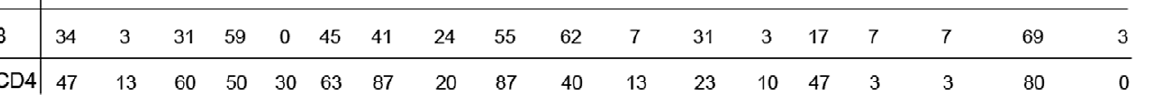
Figure 2. The help effect selectively expands fully differentiated T EM CD8 + T cells. ( A ) 1 to 2 6 10 4 CD8 + T cells were transferred alone or with 2 6 10 4 CD4 + T cells into CD3 e 2 / 2 hosts. Mice were sacrificed 8 weeks after the transfer and CD8 + CD44 high CD62L low cells from the lymph node were single-cell sorted. Multiplex RT-PCR of 19 genes was performed on 32 single-cells for the two groups. For each individual cell, black squares indicate that mRNA gene expression was detected; white squares indicate that the mRNA for the corresponding gene was absent (=0) [28]. ( B ) The table shows the percent of cells positive for each gene for the two groups of cells detailed in (A). Cytotoxic cells require co-expression of both Perforin and Granzymes A and B [27]. These cells could only be found among ‘‘helped’’ CD8 + T cells. Please note that ‘‘helped’’ CD8 + T cells harbored a significant fraction of cells expressing Il2 and Il15 mRNAs, which are very rarely expressed during antigen-specific responses and the expression of which is absent in memory T cells [28]. ‘‘Helped’’ CD8 + T cell populations also showed a higher frequency of Il7r -expressing and a lower frequency